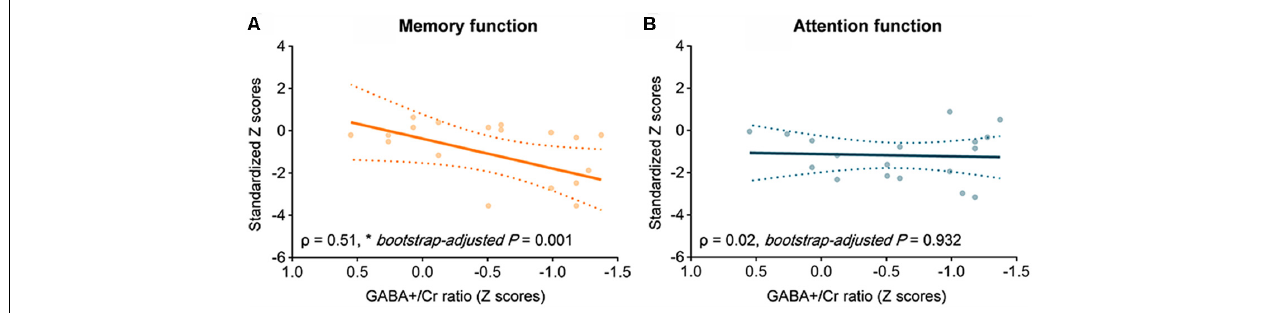
FIGURE 4 | The relationship between GABA+/Cr and cognitive performance in the Boxers group. Scatter plots with the line of best fit showing correlations between GABA+/Cr and standardized z scores of memory performance measured using the Paired Associate Learning (PAL) task. Spearman correlation analysis was used to measure correlations at the significance level of 0.05. In the Boxers group, there was a positive correlation between GABA+/Cr and performance (A) in memory task ( ρ = 0.51, z = 3.21, bootstrap-adjusted P = 0.001) but (B) not in attention task ( ρ = 0.02, z = 0.09, bootstrap-adjusted P = 0.932).